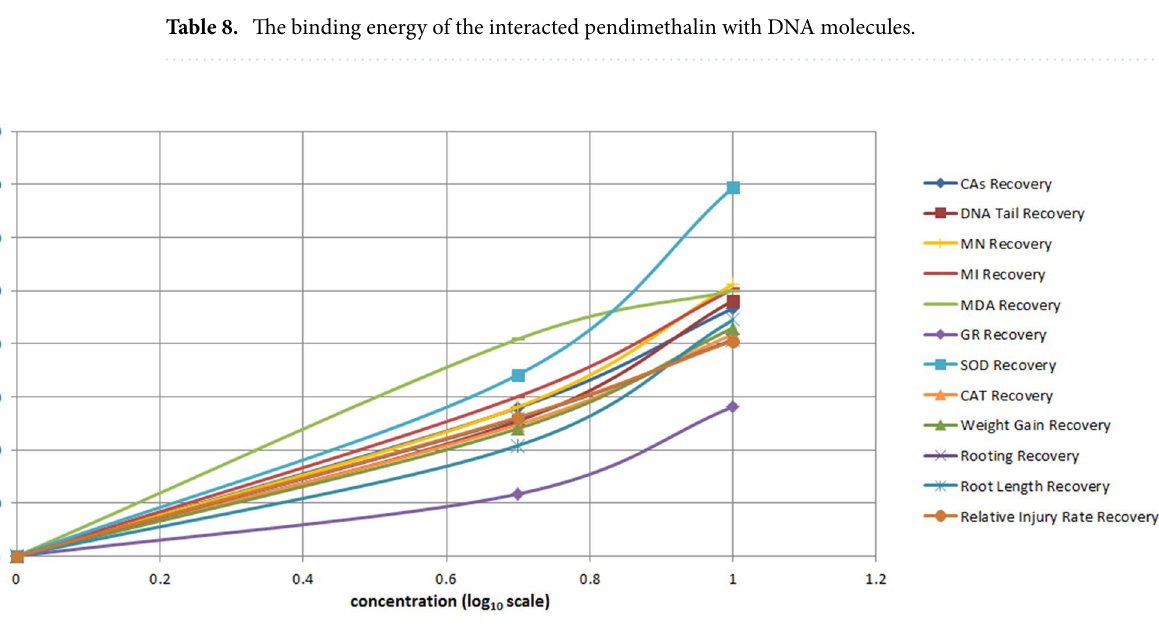
Figure 7. Dose–response protection curves of curcumin against pendimethalin